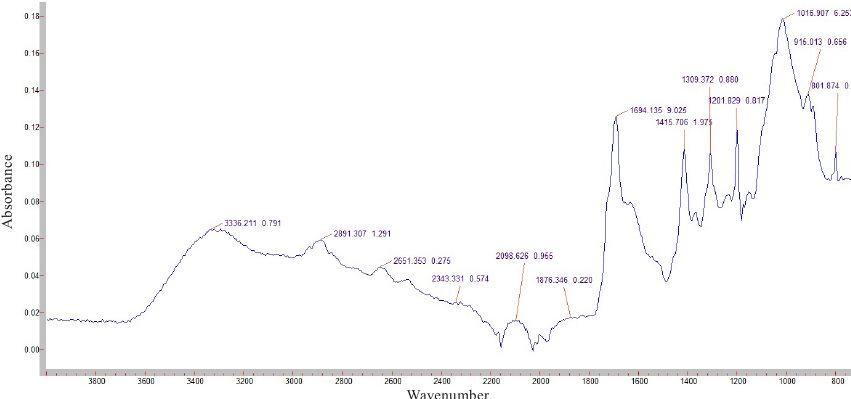
Figure 1 IR spectrum of a combined detoxicant obtained by extracting with succinic acid in an ELF EМF